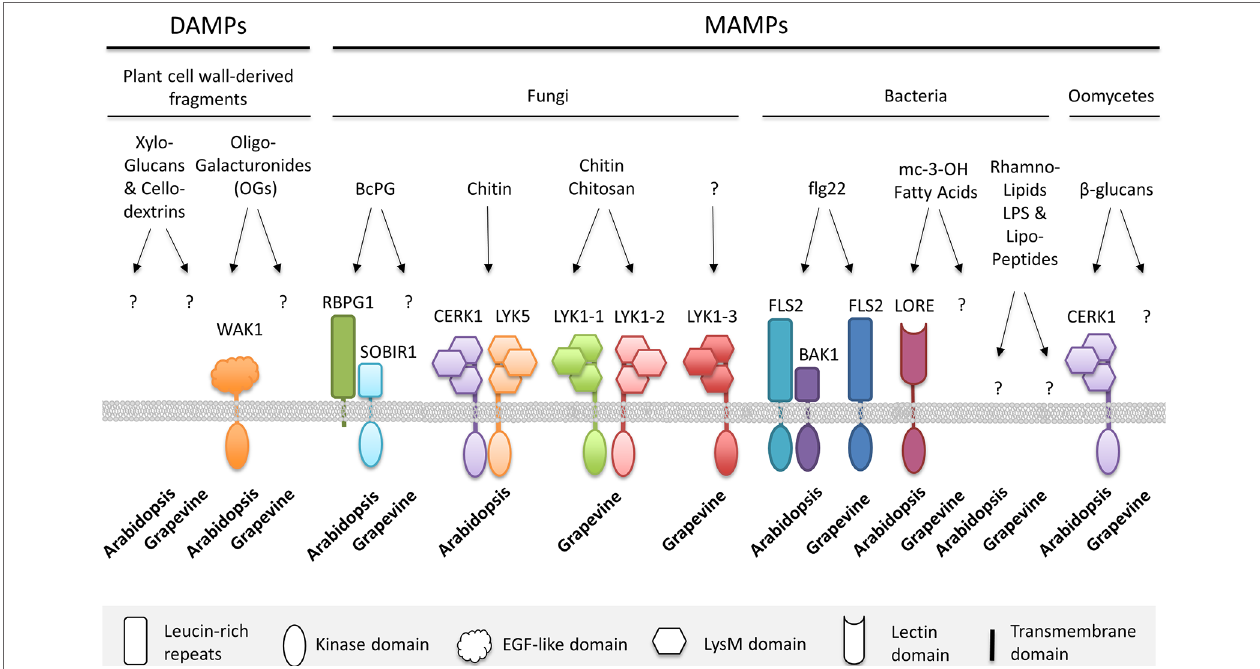
FIGURE 1 | Microbe- and damage-associated molecular patterns (MAMPs, DAMPs) recognized by grapevine or Arabidopsis pattern recognition receptors (PRRs), which trigger plant immunity. BAK1, brassinosteroid-insensitive 1 (BRI1)–associated receptor kinase 1; BcPG, B. cinerea polygalacturonase; CERK1, chitin elicitor receptor kinase 1; EGF, epidermal growth factor; FLS2, flagellin sensing 2; LORE, Lipooligosaccharide-specific reduced elicitation; LPS, lipopolysaccharide; LYK, lysin motif-containing receptor-like kinase; OGs, oligogalacturonides; RBPG1, responsiveness to botrytis polygalacturonases 1; SOBIR1, suppressor of BIR1; WAK1, wall-associated